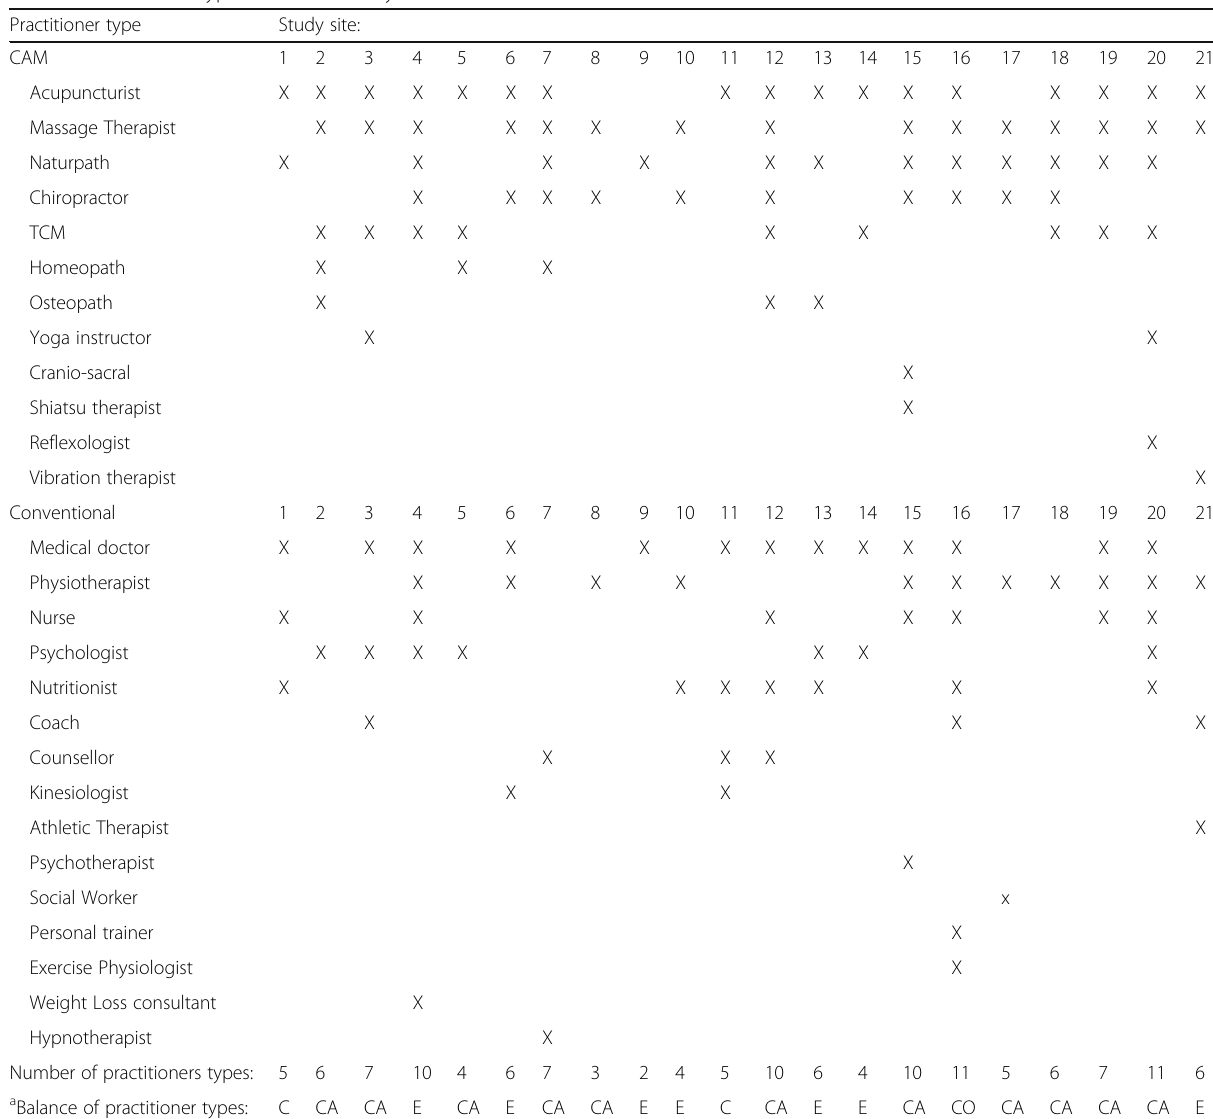
Table 2 Practitioner type mix across study sites Practitioner